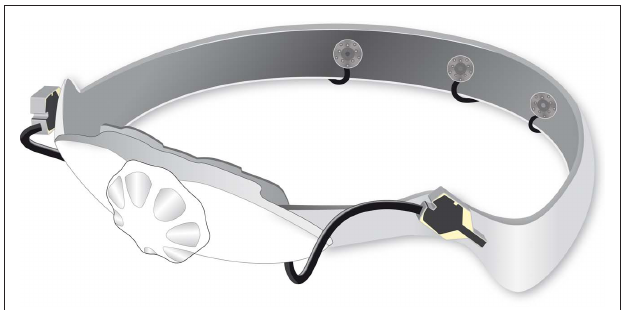
FiGurE 1 | Sketch of the prototype dry electrode cap. The three comb-like electrodes are placed inside in the back of the cap. Ground and reference are placed laterally in the front. Moreover, there is a wheel to tighten the cap to the participants’